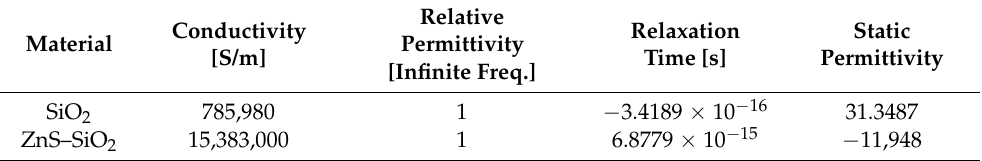
Table 3. Numerical values of the modified-Debye model for SiO 2 and ZnS–SiO 2 ( λ = 780